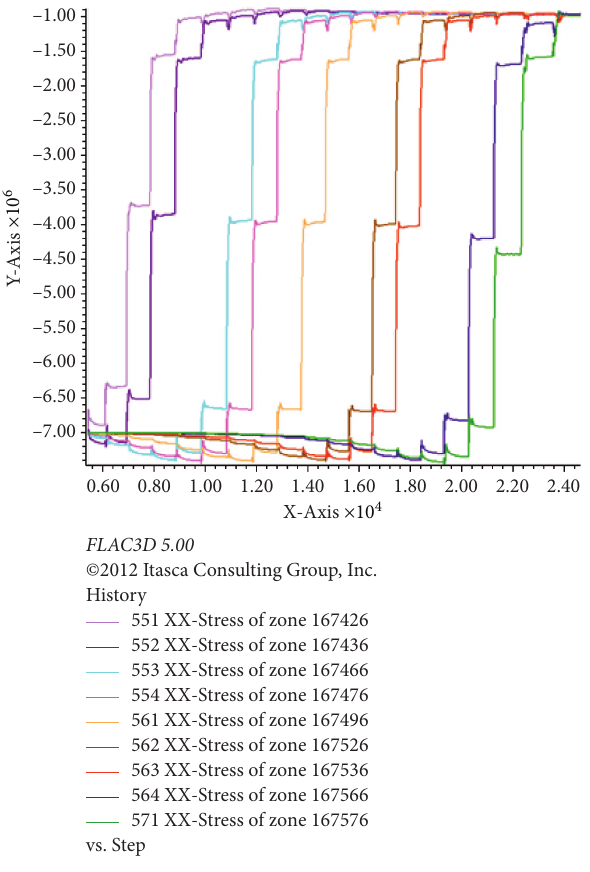
Figure 7: Stress variation curve of side